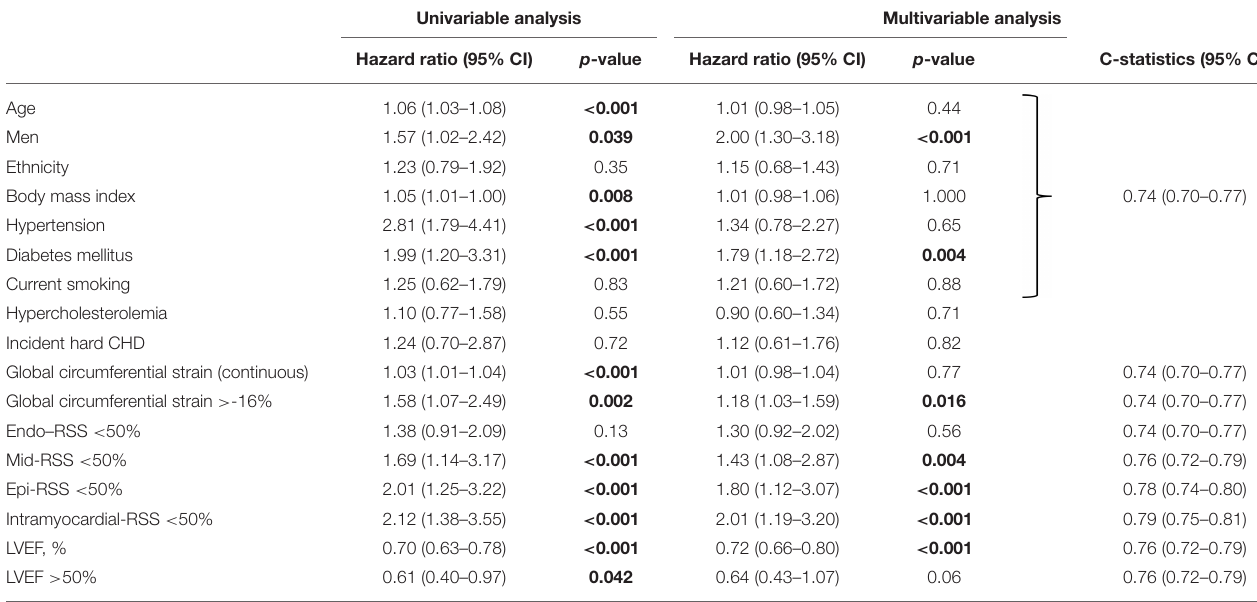
TABLE 2 | Univariable and multivariable analysis for incident HF ( N =